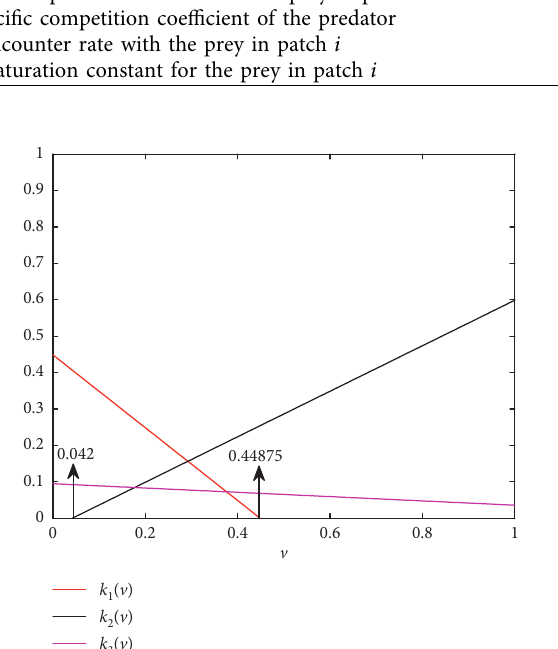
( v ) , k ( v ) , and k 1 2